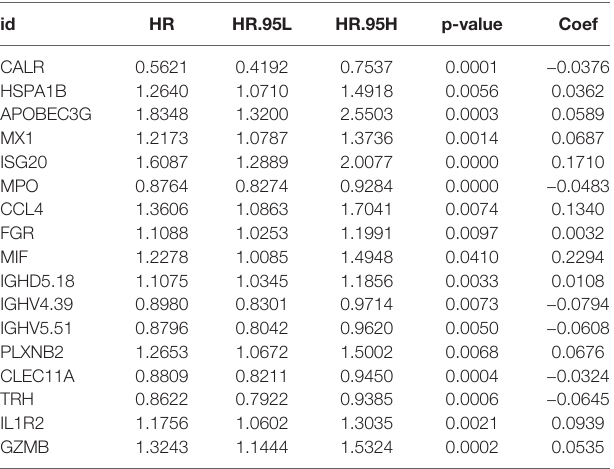
TABLE 2 | Univariate Cox regression analysis of 17 genes from immune-17 model for overall survival of TCGA-LAML patients.